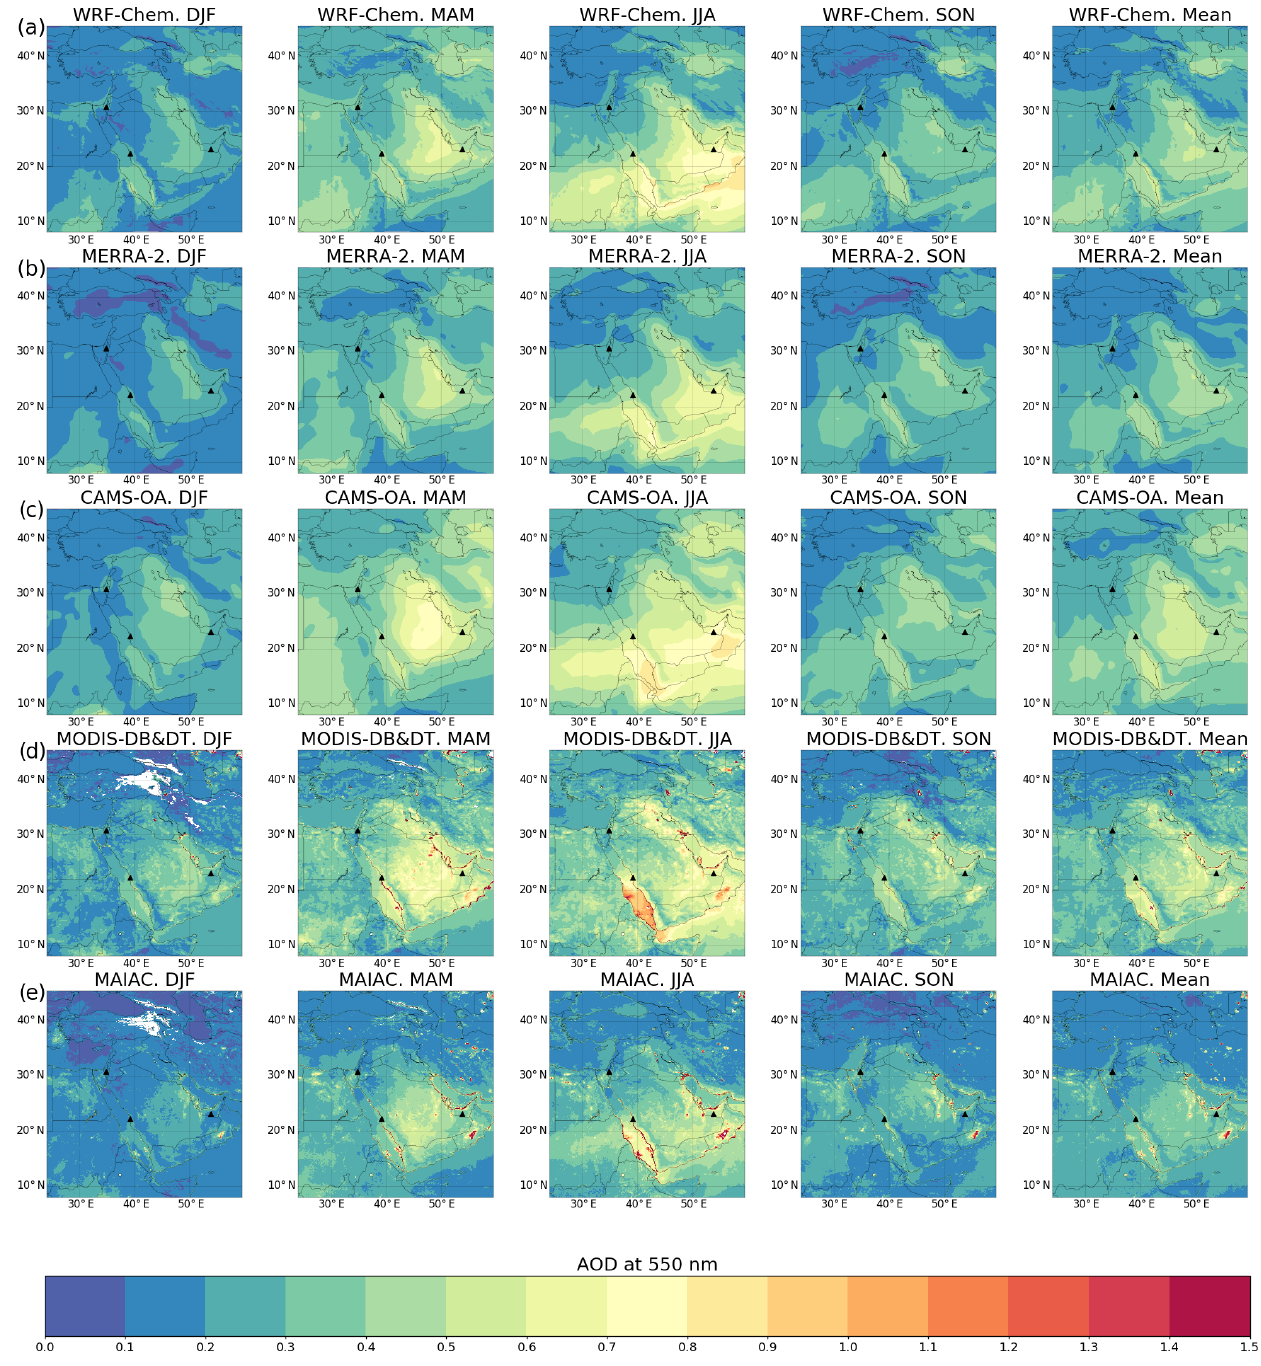
Figure 7. Seasonally averaged 2015–2016 AOD. The right column is annual mean AOD. Rows: (a) WRF-Chem, (b) MERRA-2, (c) CAMS- OA, (d) MODIS-DB&DT, and (e) MAIAC. Winter (DJF), spring (MAM), summer (JJA), and autumn (SON). White dots are undefined pixels. Black triangles denote locations of the KAUST Campus, Mezaira, and Sede Boker AERONET